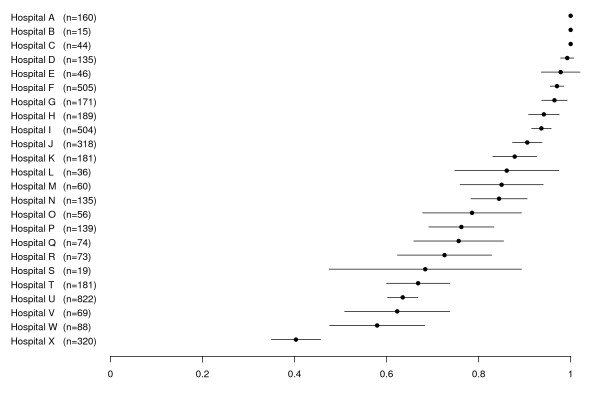
Genetic consent rates by hospital. Each hospital is labeled by letters A to H (vertical axis). Each dot and line represents the proportion of subjects at the site that consented to genetic sub-study enrollment. The central dot shows the point estimate of the site rate (percentage) generated from the random effects models. The lines extending from the dot represent the 95% confidence interval.